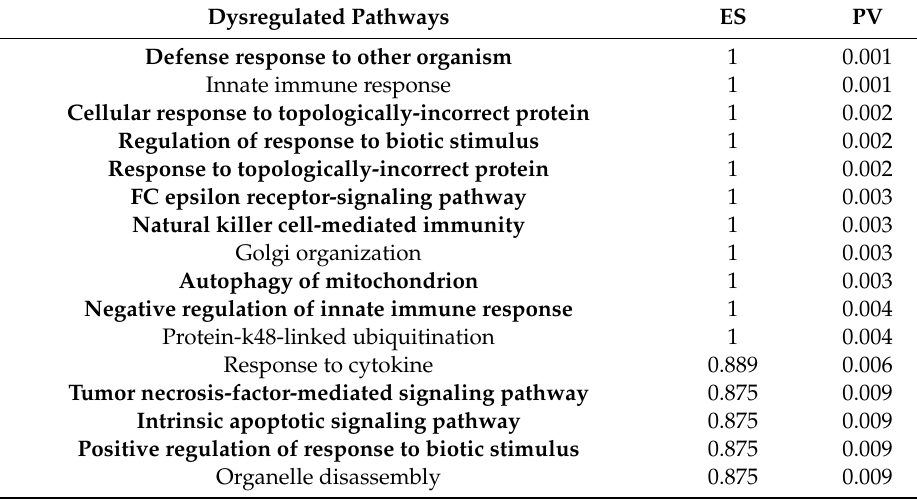
Table 1. List of dysregulated pathways of H. sapiens resulting from the differential expression analysis of the cell-death-related treatments. Significant dysregulated pathways, relative enrichment score (ES), and corresponding p -value (PV) in cell-death treatments. Dysregulated pathways associated with cell death are highlighted in bold.